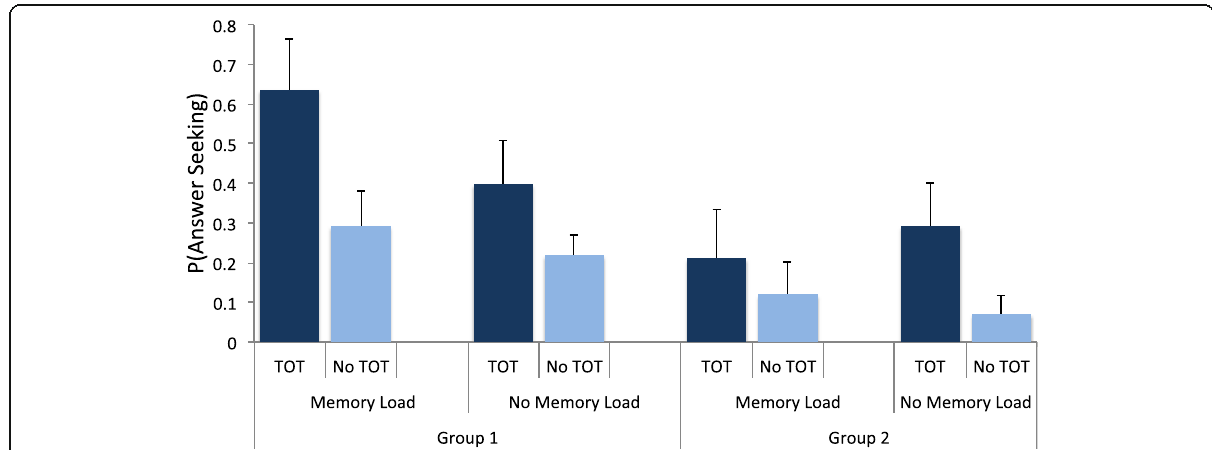
Fig. 2 Probability of answer seeking given that the response was a commission error. Error bars : standard error of the mean. TOT :